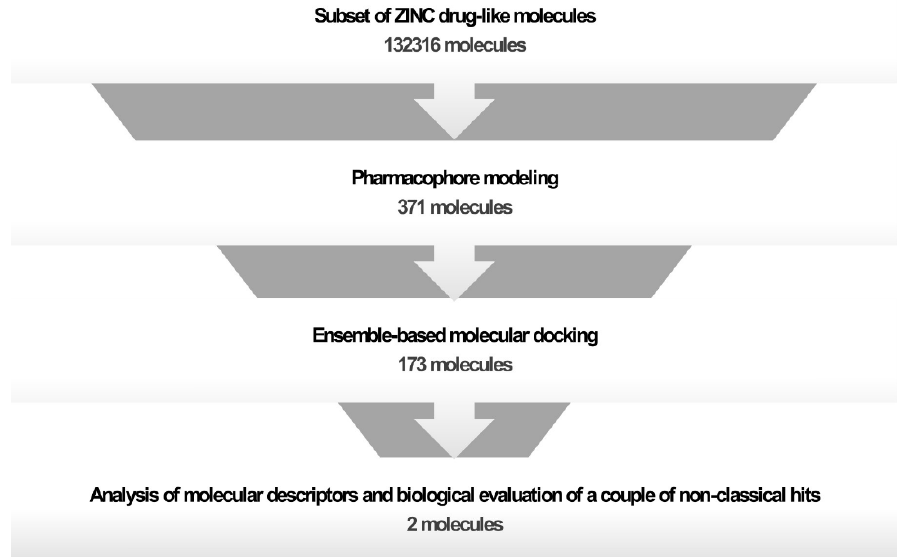
Figure 8. Schematic representation of the steps along the virtual high-throughput screening (vHTS) process. The general strategy involved the arbitrary selection of a set of drug-like molecules retrieved from the ZINC database, the combination of pharmacophore modeling and docking procedures, the analysis of molecular descriptors (MW, LogP, Jaccard–Tanimoto coefficient), and the biological evaluation of two non-classical hit compounds.